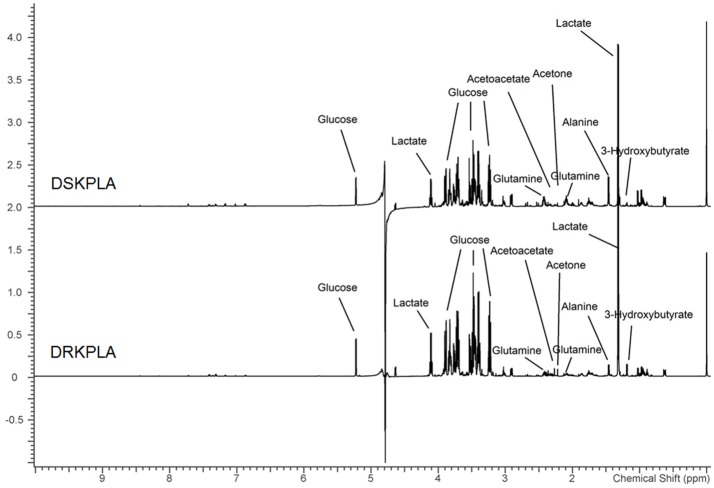
Representative 599.83 MHz 1HNMR spectra of serum samples from a DSKPLA and a DRKPLA patient. The key metabolites are noted.